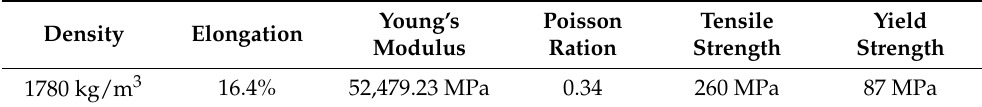
Young’s Modulus